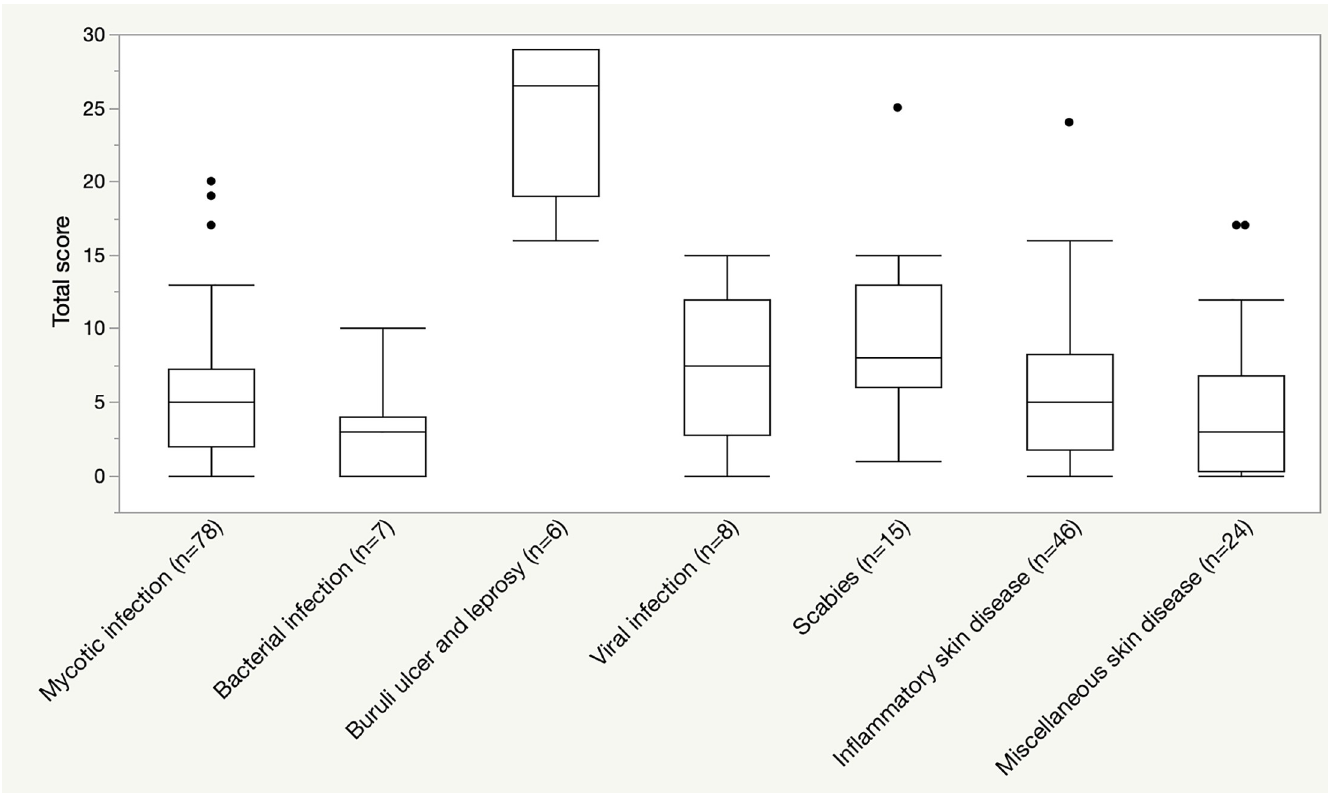
Fig 3. Distribution of CDLQI score by disease groups.